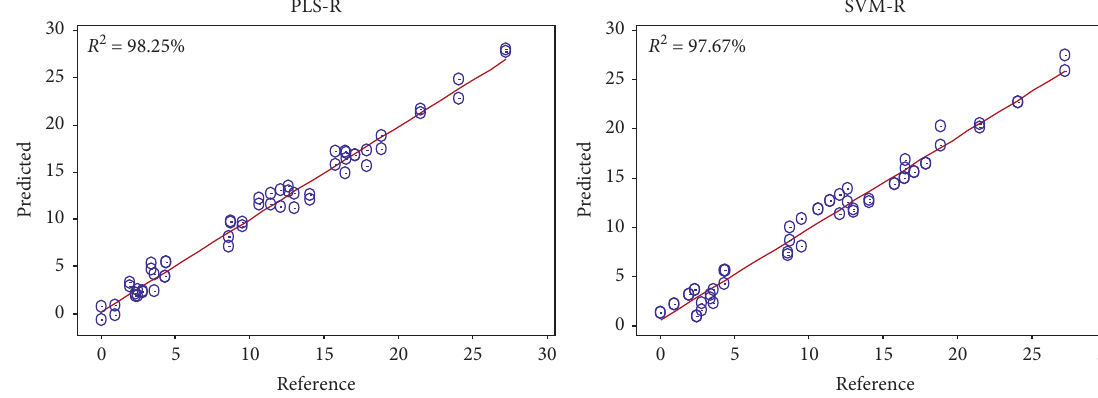
Figure 5: Example of PLS-R and SVM-R calibration models of honey adulteration.